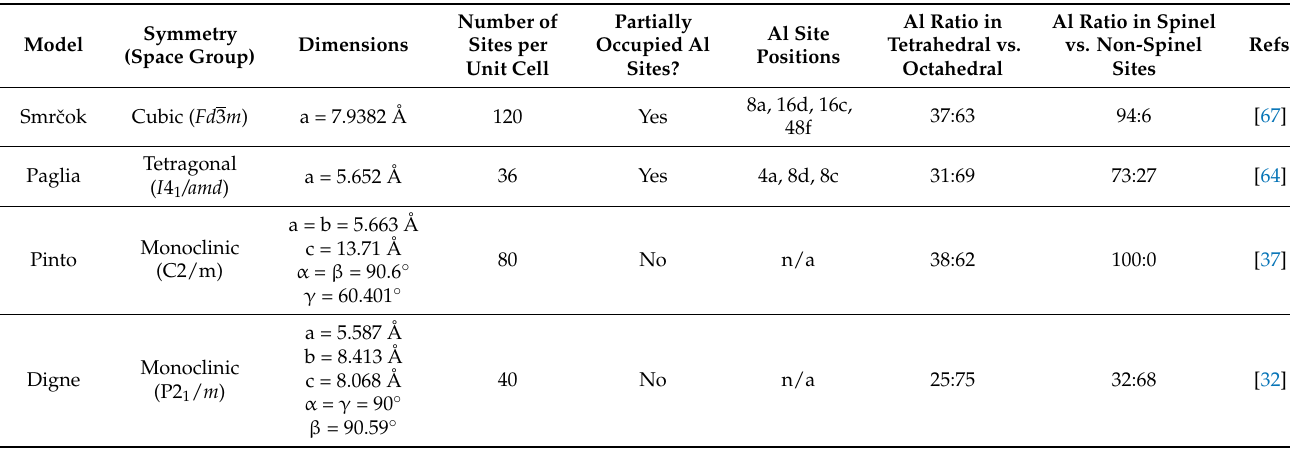
Table 1. Structural details of four γ -alumina bulk models. Reprinted from Acta Materialia, Vol 182, Henry O. Ayoola, Stephen D. House, Cecile S. Bonifacio, Kim Kisslinger, Wissam A. Saidi, Judith C. Yang, Evaluating the accuracy of common γ -Al 2 O 3 structure models by selected area electron diffraction from high-quality crystalline 2020, with permission from